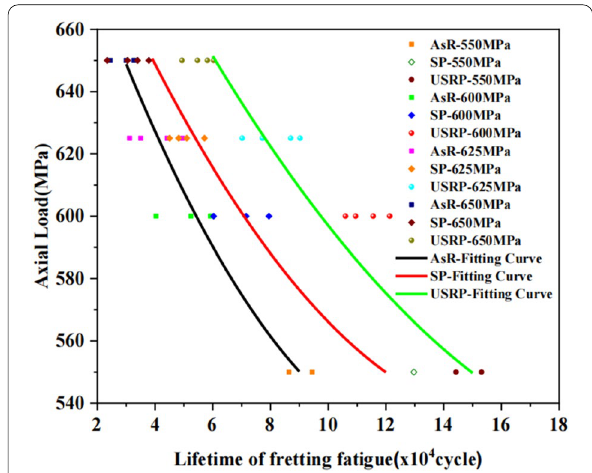
Figure 17 Fretting fatigue life of AsR, SP and USRP